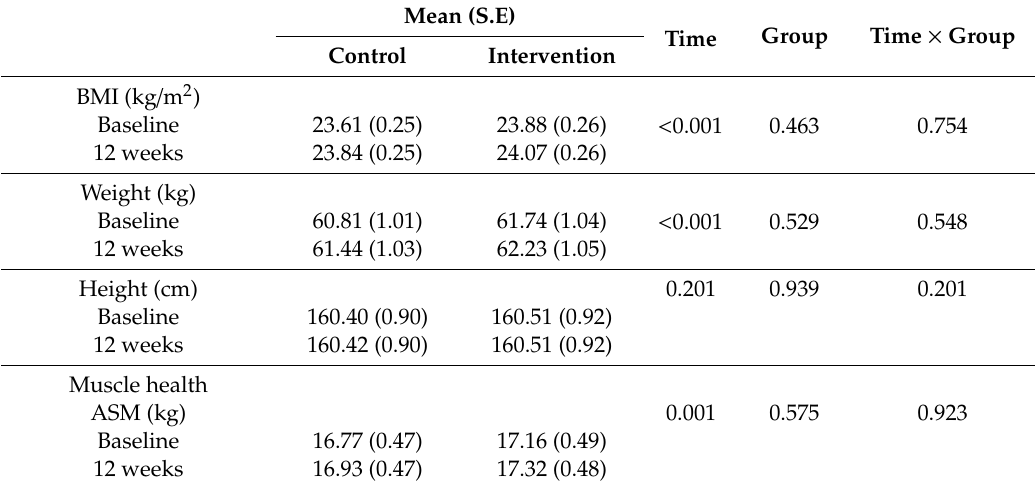
Table 3. Muscle health and physical performance changes during the 12-week study